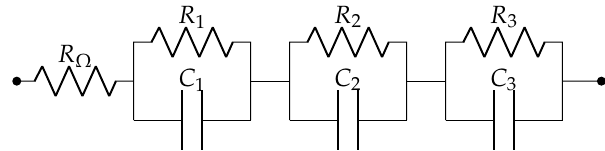
Figure 1. Third-order linear RC model ( N p =